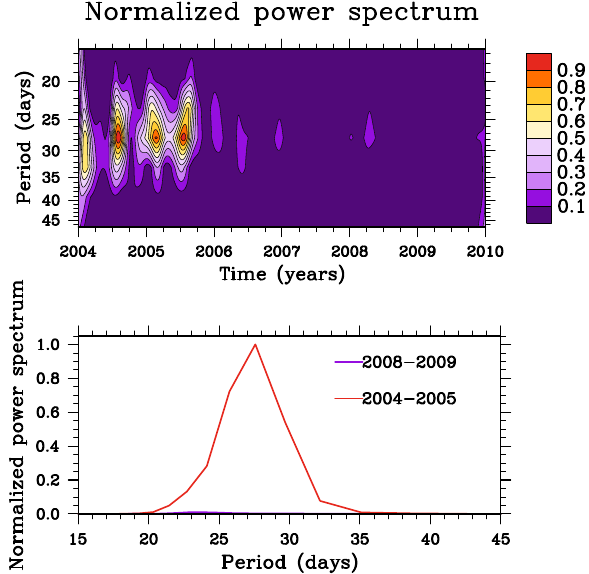
Fig. 4. The wavelet analysis (top panel) and the normalized power spectra (bottom panel) of the unfiltered Ly- α irradiance as measured by